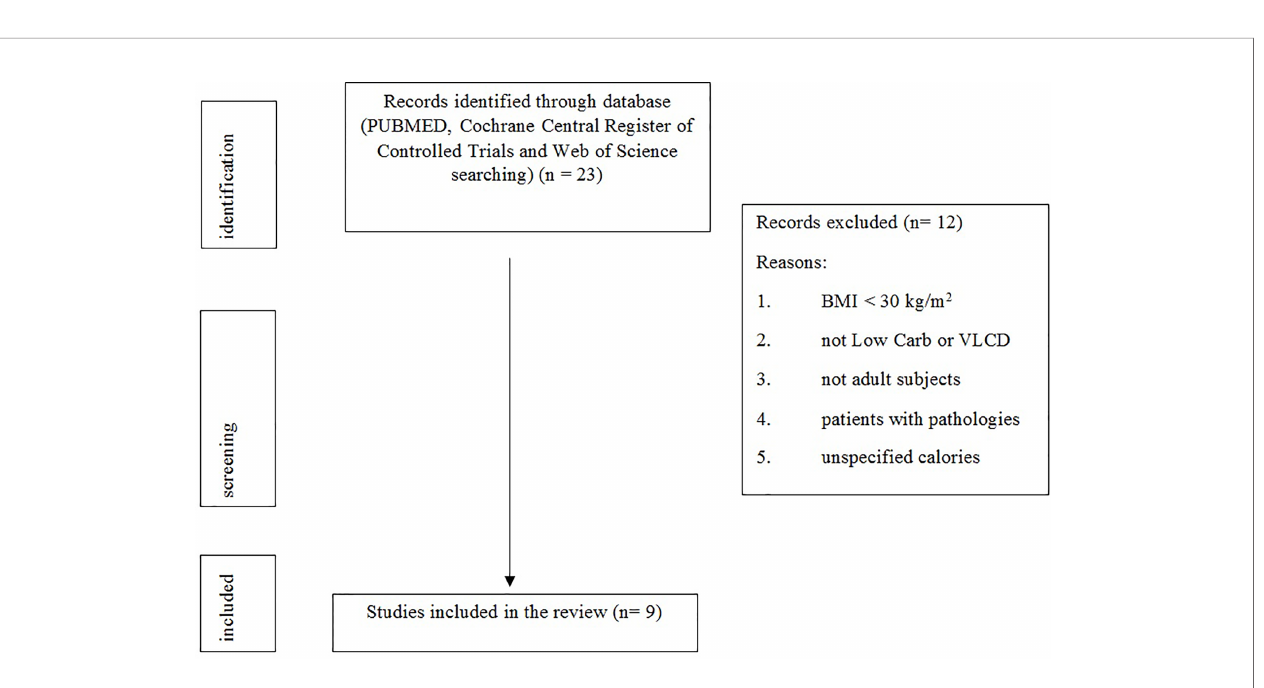
FIGURE 1 | Flow diagram of the review